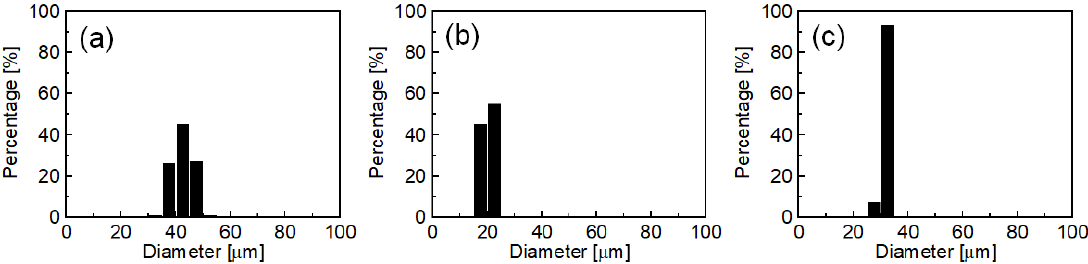
Figure 6. Number-weighted droplet diameter distributions of O/W emulsions obtained by MC emulsification using ( a ) MC-A, ( b ) MC plate type B (MC-B), and ( c ) MC plate type C (MC-C) (see Section 3.2). SC concentration was 3 wt%, and emulsification temperature was 60 °C. Each histogram contains data on diameter for more than 100 droplets.